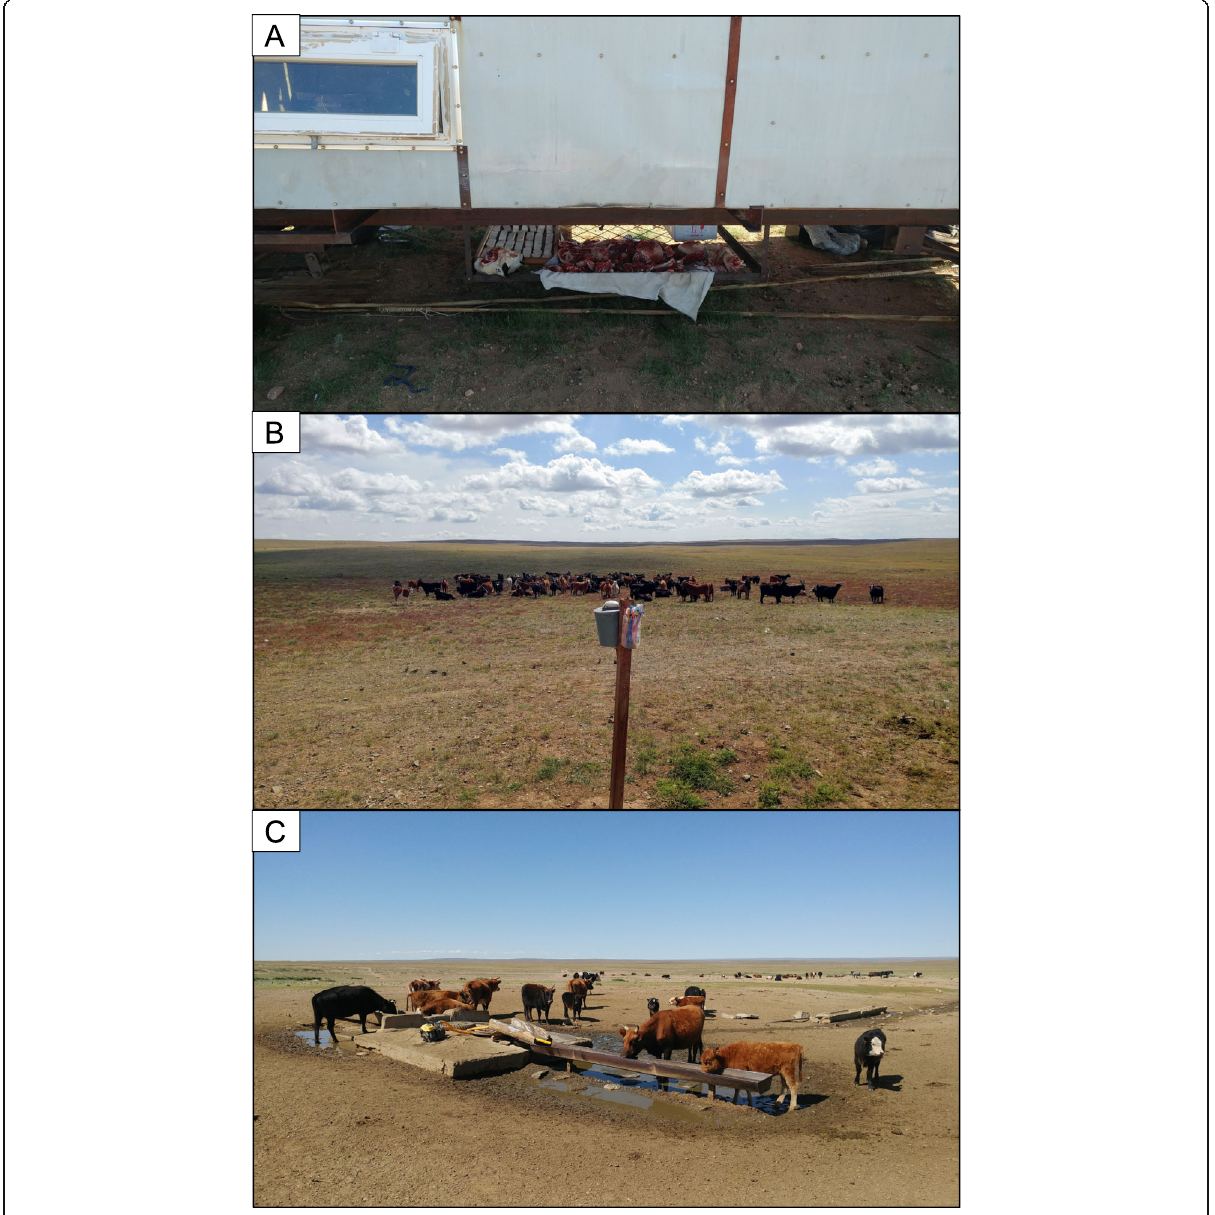
Fig. 2 Photographs of water and hygiene risks at rural herder sampling sites in Dundgovi province were taken by author Amber N. Barnes during field work. A recently slaughtered sheep has been left to dry next to aaruul under a household storage building ( a ), household toothbrushes and handwashing soap and water are stationed outside next to grazing livestock ( b ), and a drinking water well is being shared between several households, livestock, and wildlife ( c